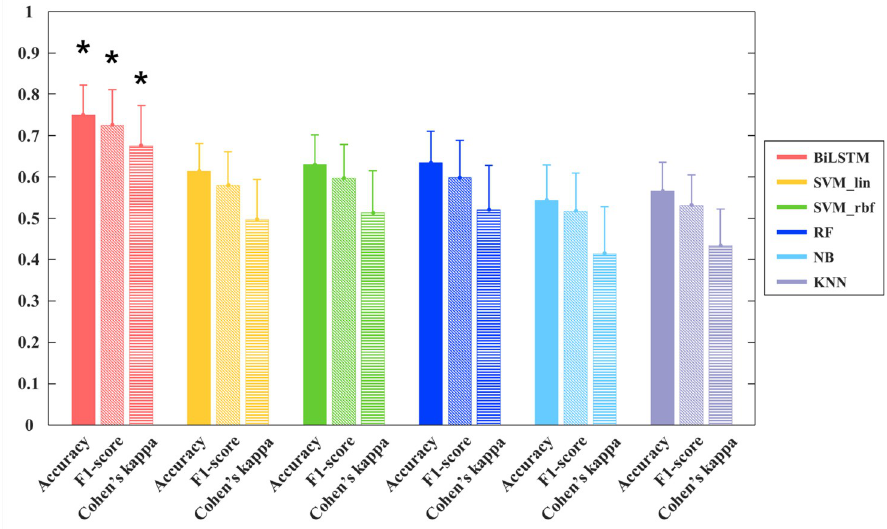
Fig 6. Comparison of the performance of the BiLSTM network and other conventional machine learning methods. The bar plots with standard deviation were drawn using the results of 10-fold cross-validation of each subject. Each bar represents accuracy (entire), f1-score (diagonal), and Cohen’s kappa statistic κ (horizon) of each classifier. Asterisk ( � ) above the bar plot indicates the significant differences ( p < 0.01) between the performance of the BiLSTM and all other conventional machine learning methods. BiLSTM, bidirectional long short-term memory; SVM_lin, support vector machine with linear kernel; SVM_rbf, support vector machine with radial basis function kernel; RF, random forests; NB, na ï ve Bayes; KNN, k-nearest neighbors.